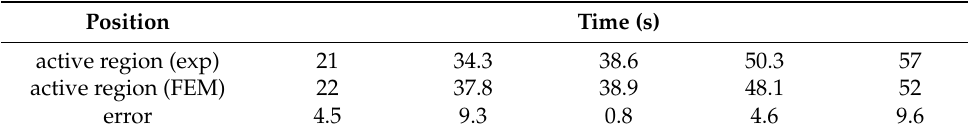
Table 3. Error simulation and experiment.